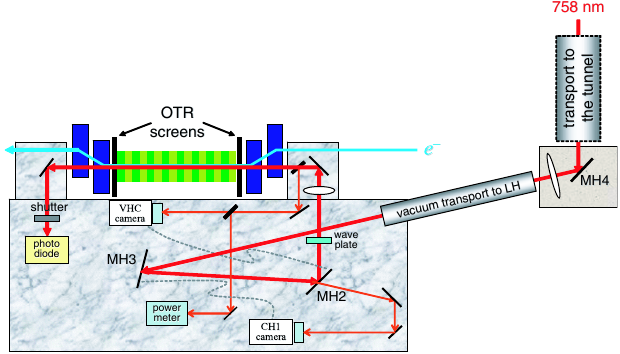
FIG. 2. (Color) The layout of the laser-heater system showing LH chicane, undulator, OTR screens, laser transport, motorized mirrors, cameras, wave plate, power meter, and